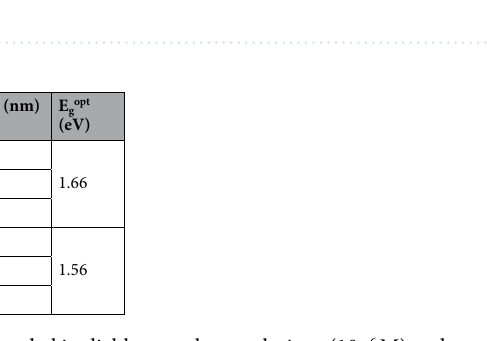
Figure 4. UV-Vis absorption spectra of 1,6-i (blue line) and 1,7-i (red line) in CH 2 Cl 2 (left) and as thin film on glass (right).